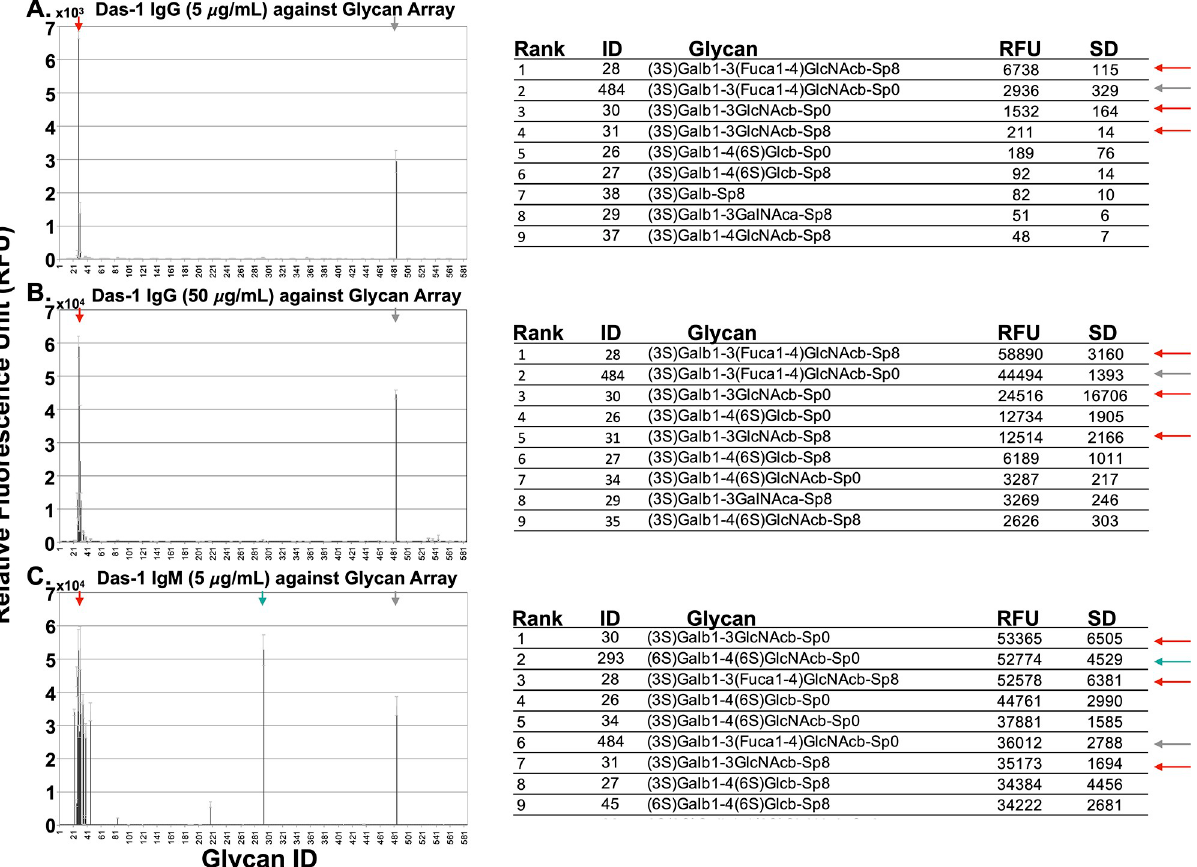
Fig 3. The results of the glycan arrays. Das-1 IgG (at 5 & 50 μ g/mL) and Das-1 IgM (at 5 μ g/mL) are plotted in A, B, and C respectively as the average relative fluorescence units (of 6 technical replicates) plus/minus standard deviation. The top 9 glycans for each arrays are listed to the right of each figure. Colored arrows emphasize that Das-1 IgG and Das-1 IgM recognize the same set of glycans. The complete data sets are provided in S1 Dataset (5 μ g/mL IgG), S2 Dataset (50 μ g/mL IgG), and S3 Dataset (5 μ g/mL IgM) and are available for download on the Consortium for Functional Glycomics website